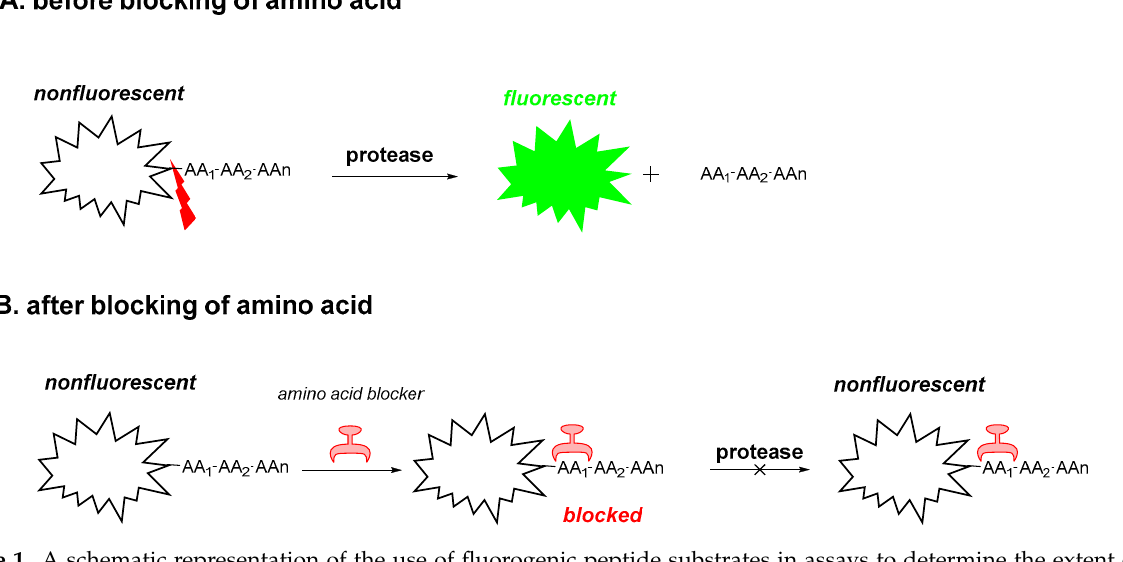
Figure 1. A schematic representation of the use of fluorogenic peptide substrates in assays to determine the extent of chemical modification of endogenous amino acids. ( A ) An increase in fluorescence on proteolysis of a fluorogenic peptide substrate by a protease; ( B ) A reduction in fluorescence following chemical modification of an endogenous amino acid at the proteolytic site of the fluorogenic peptide substrate.